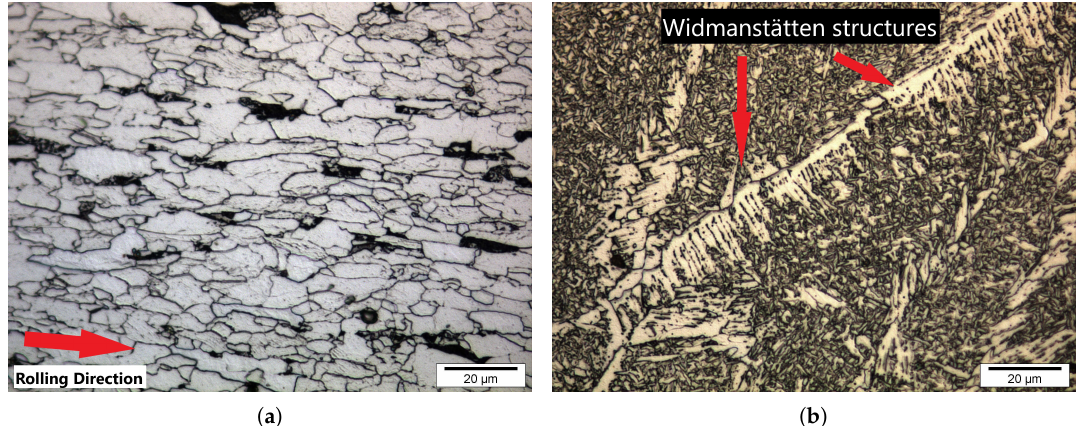
Figure 2. ( a ) Microstructure of the base metal (BM) consisting of polygonal ferrite with small pearlite islands (black). ( b ) Microstructure the weld metal (WM) consisting mainly of acicular ferrite with Widmanstätten ferrite at the prior austenite grain boundaries as indicated.